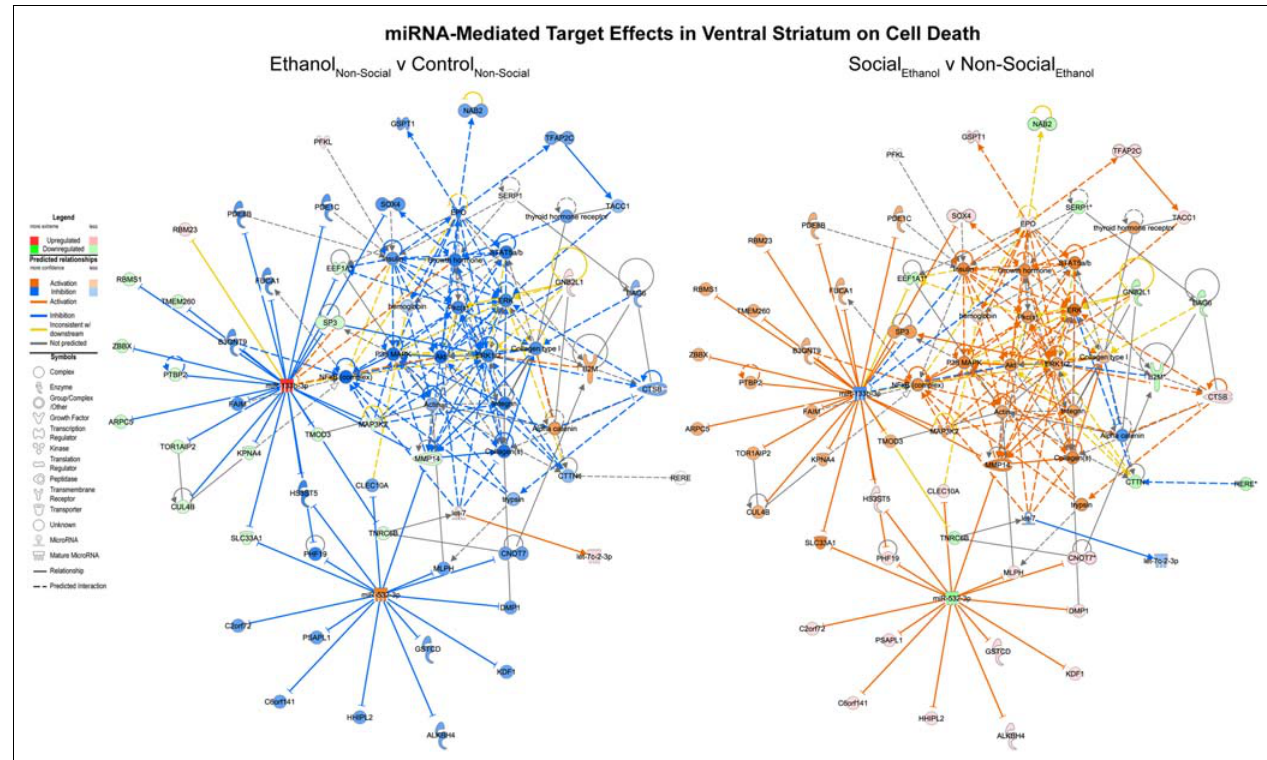
FIGURE 5 | MicroRNA target effects in the ventral striatum on cell death signaling . Conventions same as Figure 3 . Note that nearly all of the genes show a distinct reversal in their expression difference following social